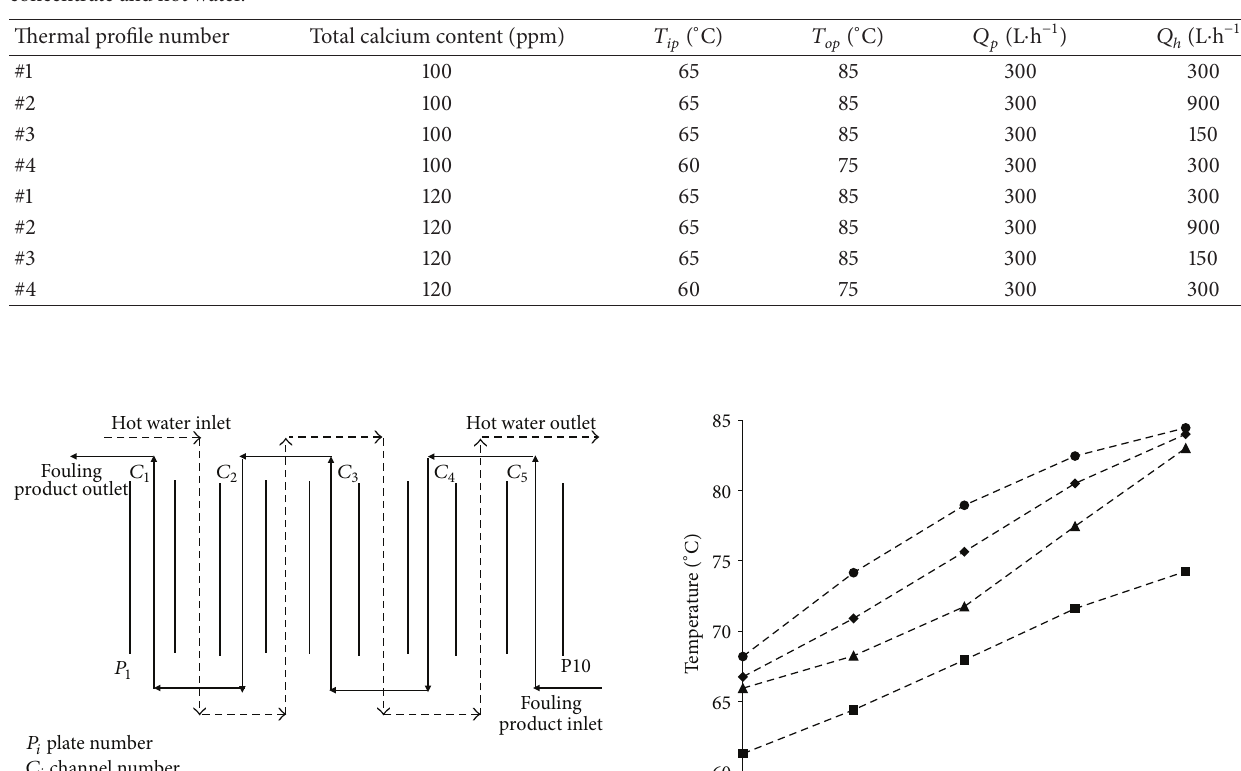
Table 2: Operating conditions investigated with the pilot scale experimental set: mean inlet and outlet temperatures and flow rates of 𝛽 -Lg concentrate and hot water.